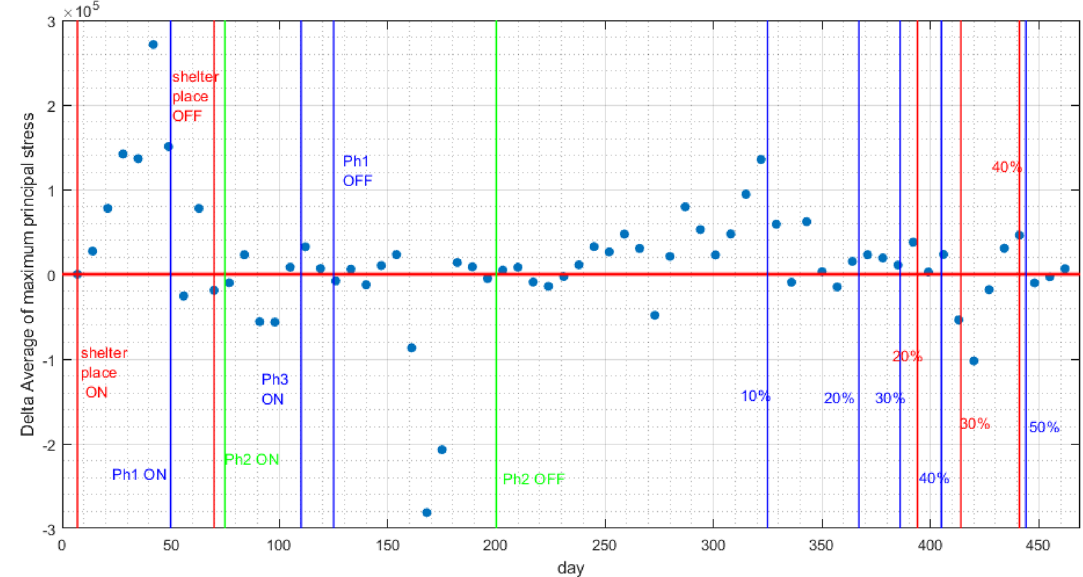
Figure 8. The effect of Governments’ actions on the pandemic growth rate: growth rate is the values of the signal in this figure, such that for any day that signal is positive, the pandemic is growing, and for any day that signal is negative, the pandemic is shrinking.